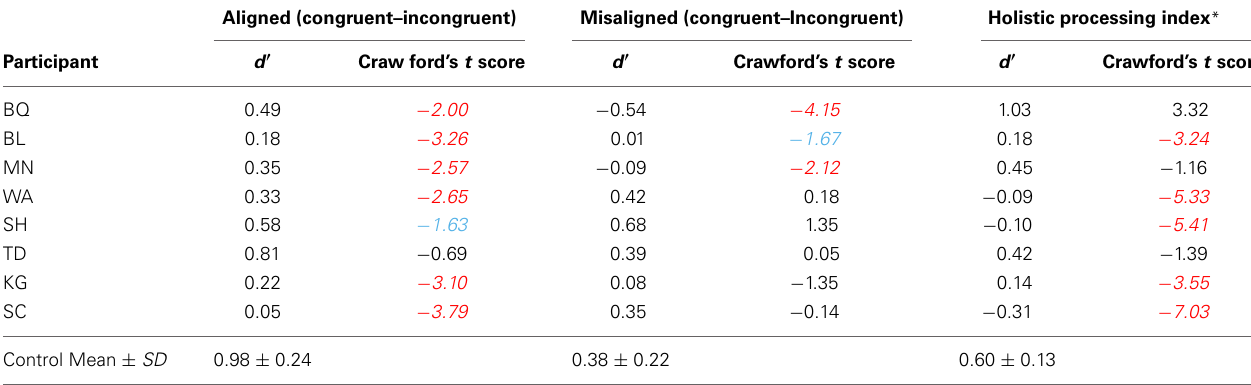
Table 2 | Crawford’s t -test scores of the aligned congruency index, misaligned congruency, and the holistic processing index for each individual CP participant.